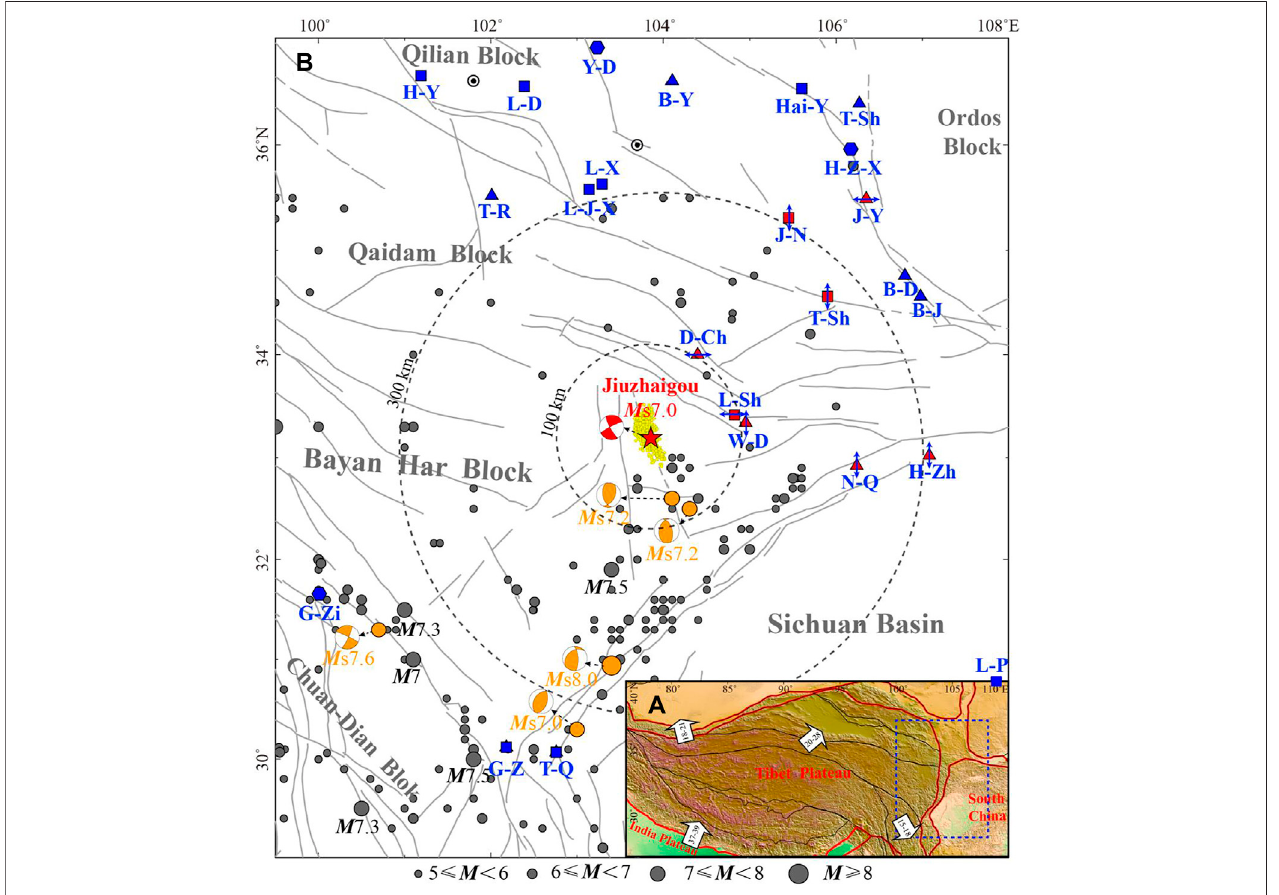
FIGURE1|(A) Locationdiagramofthestudyarea.Redlines:primaryblockboundary;Blacklines:secondaryblockboundary;Blackarrow:movementdirectionof the plate; Blue dotted rectangle: location of Figure 1B . (B) Regional tectonic setting, historical earthquake, and strain observation stations distribution around JZGEQ. Gray dots: seismic events above M s5 in the study area since 1900s; Orange dots: Seismic events above M s7 since 1970s; Focal mechanism: epicenter events above M s7since1970s(citefromGCMT);Graycircle:epicentraldistanceof100and300 km;Triangle:cavestrainmeterstation;Square:four-gaugeboreholestrainmeter station;Hexagonal:volumetricboreholestrainmeterstation;Redicon:stationsin Figure2 ;Bluearrow:directionofthestrainobservation;L-Sh:Liang-Shuistation;W-D: Wu-Dustation;D-Ch:Dang-Changstation;N-Q:Ning-Qiangstation;H-Zh:Han-Zhongstation;T-Sh:Tian-Shuistation;J-N:Jing-Ningstation;B-J:Bao-Jistation;B-D: Ba-Du station; J-Y: Jing-Yuan station; L-J-X: Liu-Jia-Xia station; L-X: Lin-Xia station; T-R: Tong-Ren station; H-Z-X: Hai-Zi-Xia station; T-Sh: Tan-Shan station; Hai-Y: Hai-Yuanstation;B-Y:Bai-Yinstation;Y-D:Yong-Dengstation;L-D:Le-Dustation;H-Y:Huang-Yuanstation;G-Zi:Gan-Zistation;G-Z:Gu-Zanstation;T-Q:Tian-Quan station; L-P: Liang-Ping